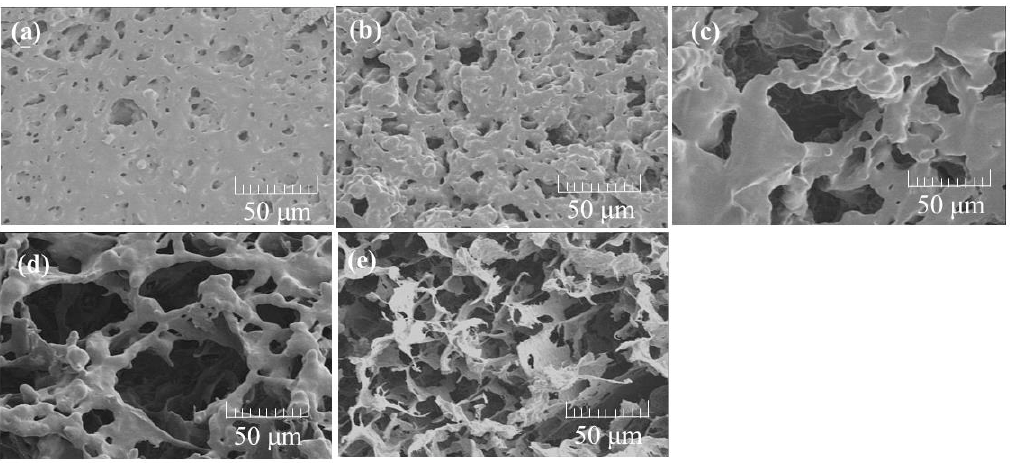
Figure 8. SEM images of ( a ) NR sheet; and ( b – e ) self-assembled CNF-NR composite porous materials (CNF:NR (weight ratio) = 0.01, 0.02, 0.1, 0.2:1, respectively).